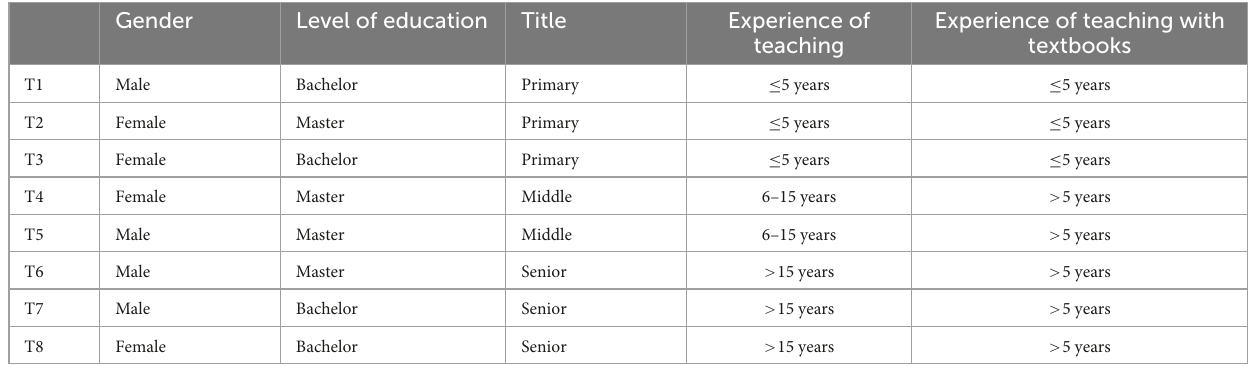
TABLE 3 Basic information of teachers